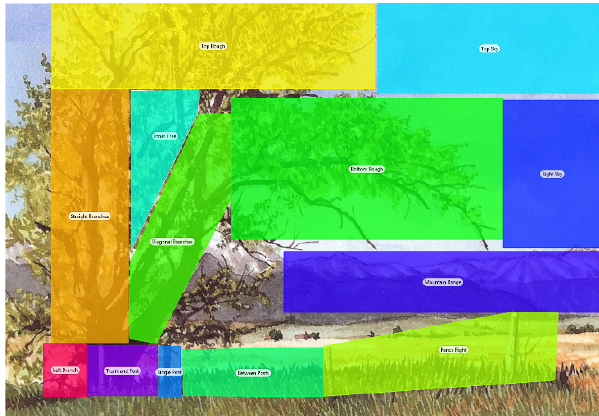
Figure 1: Example of compositional AOI elements Thereafter, each AOI was named using an alphabetic character, starting at A for the first expected AOI in the intended composition and proceeding